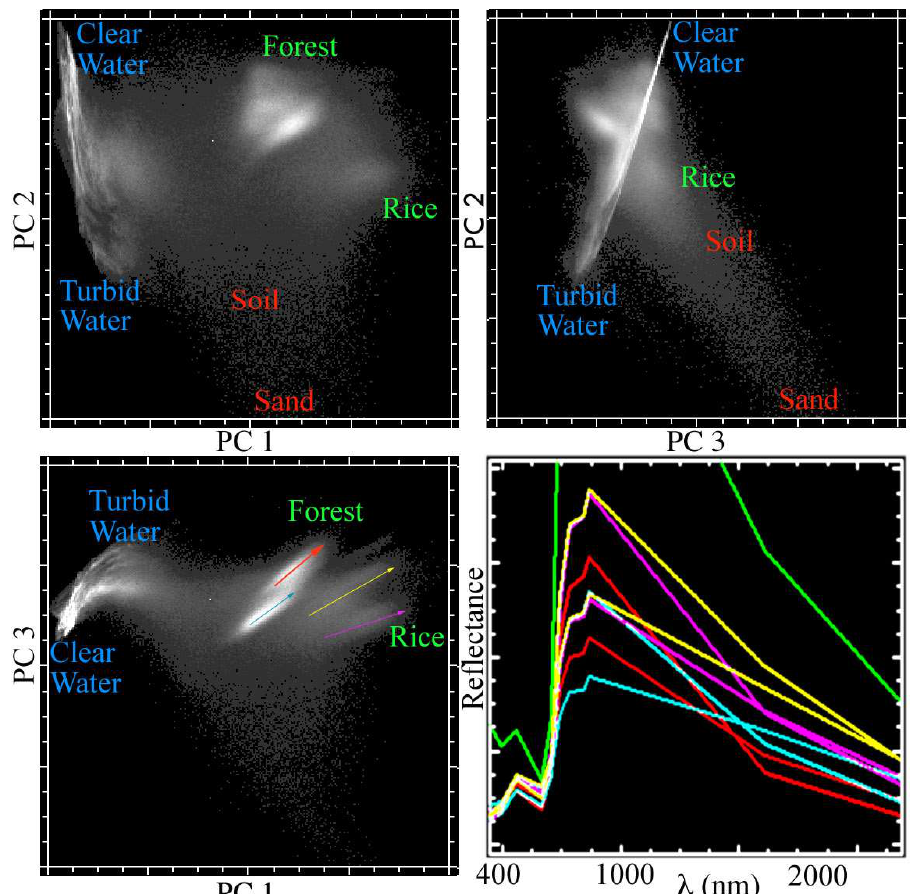
Figure 2. The spectral mixing space for the Sentinel 2 HLS product T45QYE on julian day 322 of 2018. Projected onto the global S2 mixing space (top, color), the range of reflectances is compressed, but the local space (bottom) clearly resolves multiple mixing trends (arrows) between distinct endmembers and shadow. The color of the vegetation spectra corresponds to the color of the mixing trend arrow on the PC1 / PC3